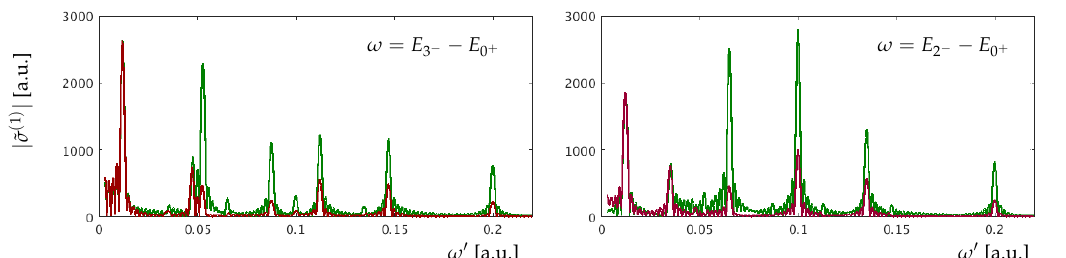
Figure 6. Fourier spectrum of the oscillations at the ω = E 3 − − E 0 + and ω = E 2 − − E 0 + peaks (green: (cid:104) 3 − | ˆ Z | 0 + (cid:105) = 0.33; red: (cid:104) 3 − | ˆ Z | 0 + (cid:105) = −